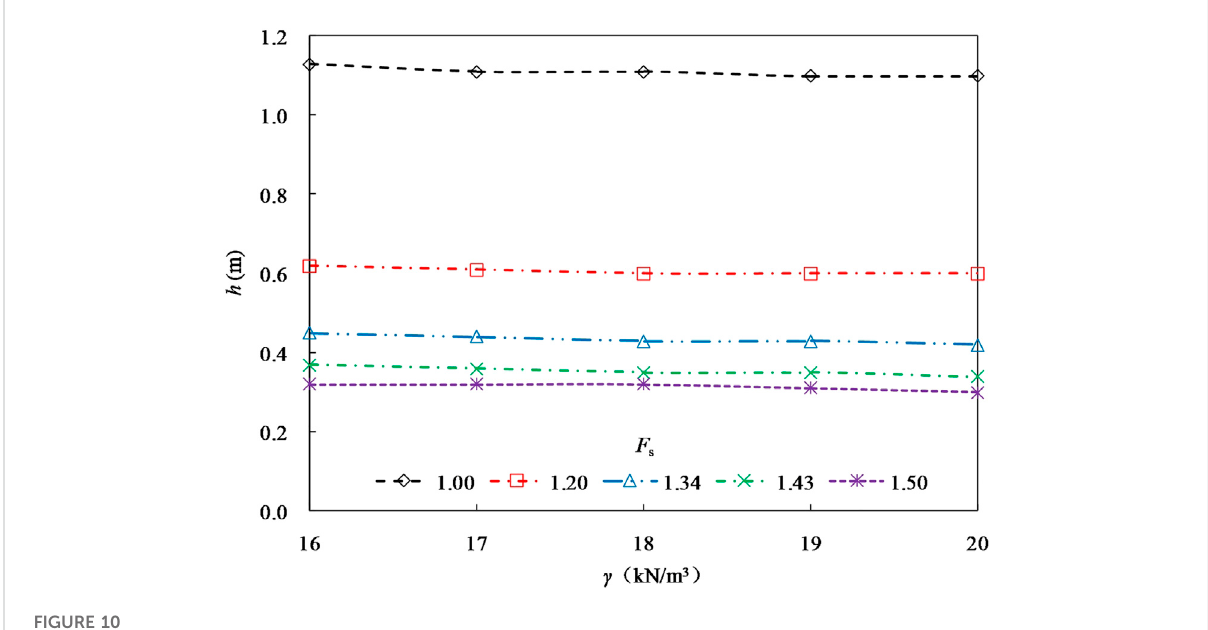
FIGURE 10 Relationship between h and γ under different F s .